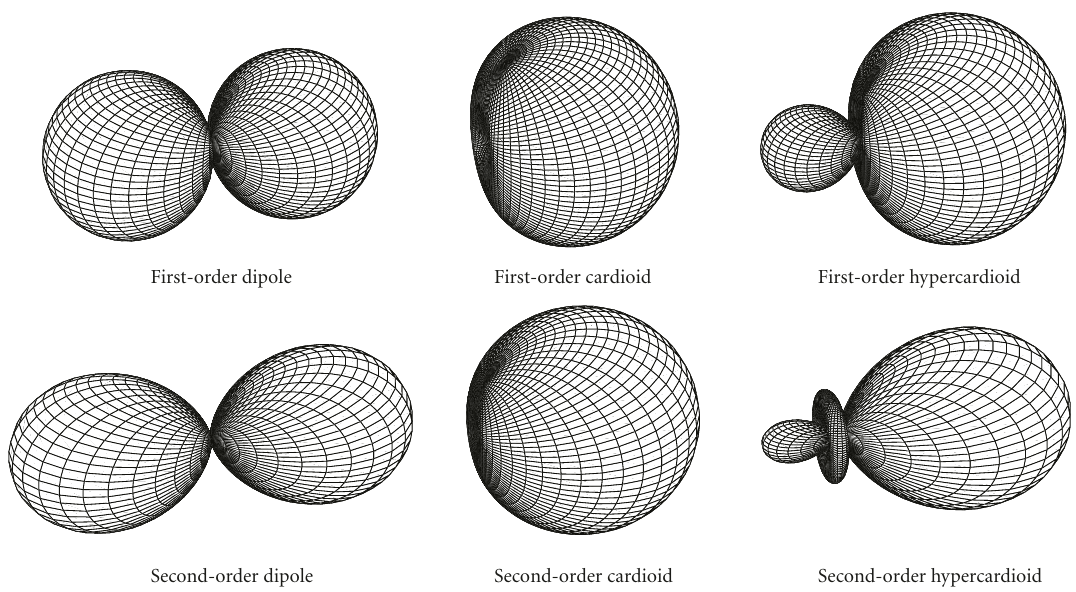
Figure 5: This figure illustrates three first- and second-order antenna responses, that is, dipole, cardioid, and